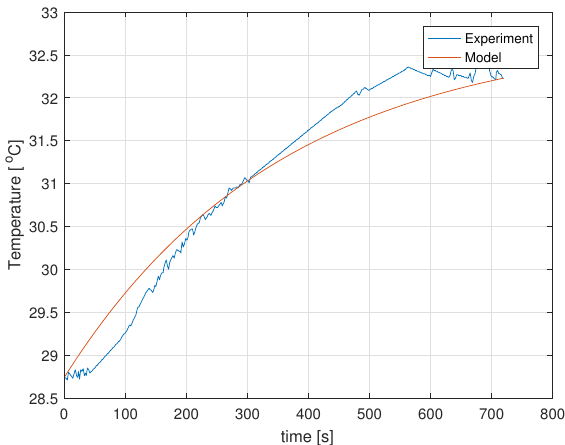
Figure 11. The step responses of the IO model and real plant for area 3.